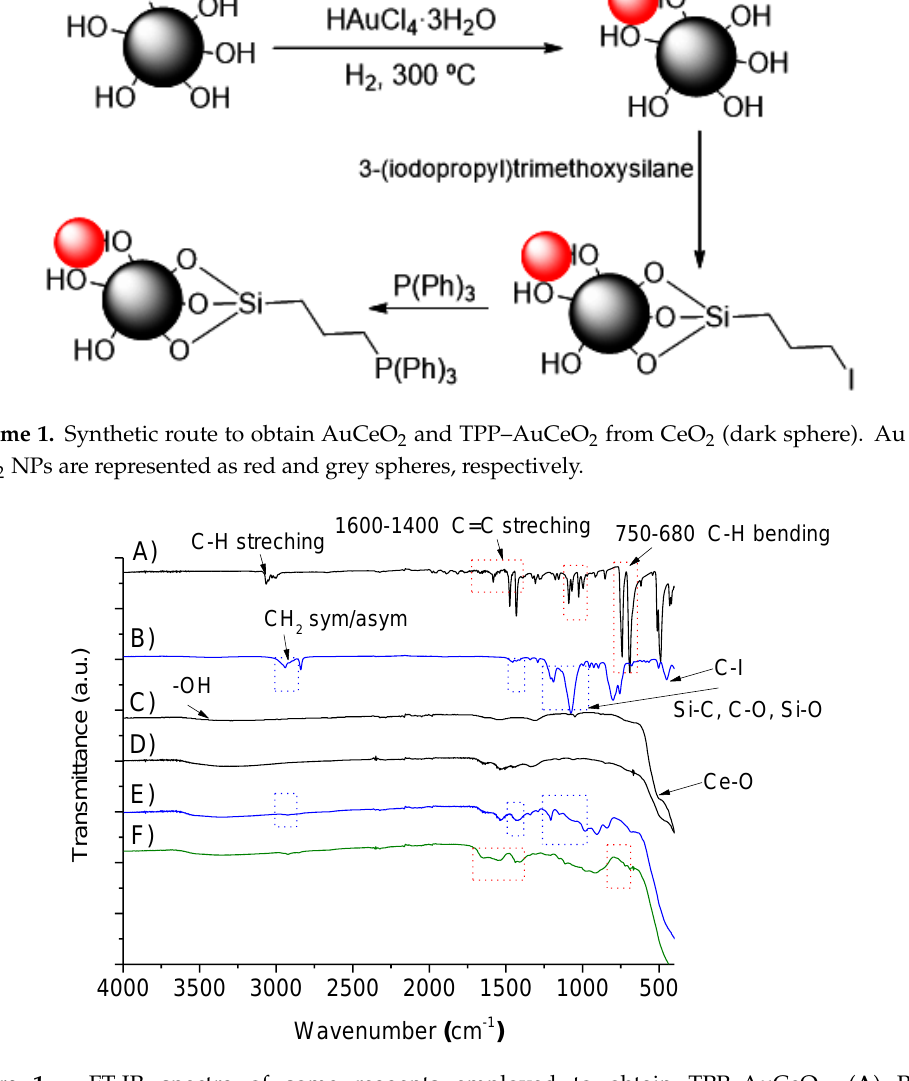
Figure 1. FT-IR spectra of some reagents employed to obtain TPP–AuCeO 2. ( A ) PPh 3 , ( B ) Si(MeO) 3 –propyl–I, ( C ) CeO 2 , ( D ) AuCeO 2 , ( E ) I–AuCeO 2 , and ( F ) TPP–AuCeO 2 . The main bands employed to identify different functional groups are labelled in the spectra.